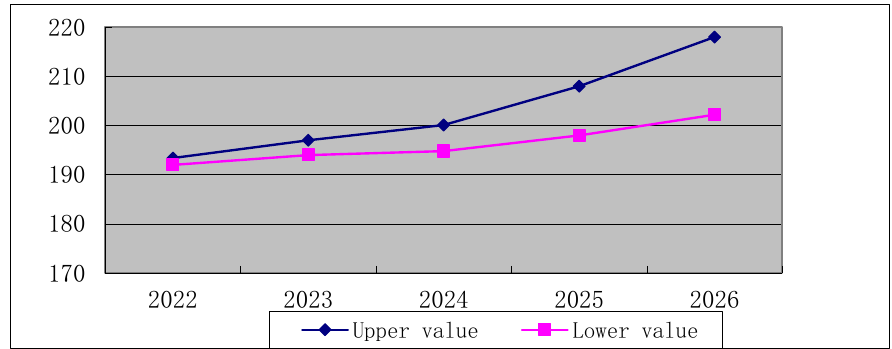
Figure 19. The variation interval of water requirement with the influence of the secondary industry in Inner Mongolia.